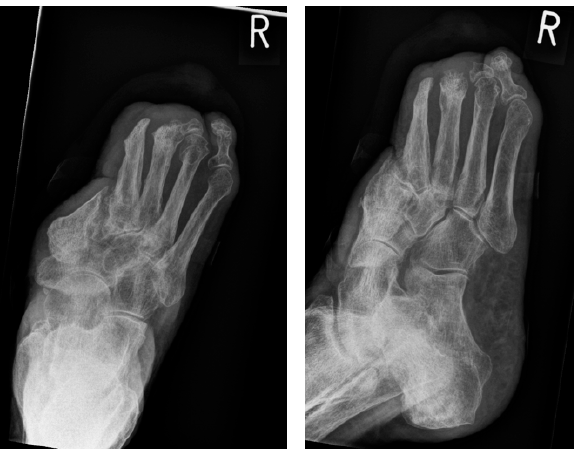
Figure 9. Radiological imaging.